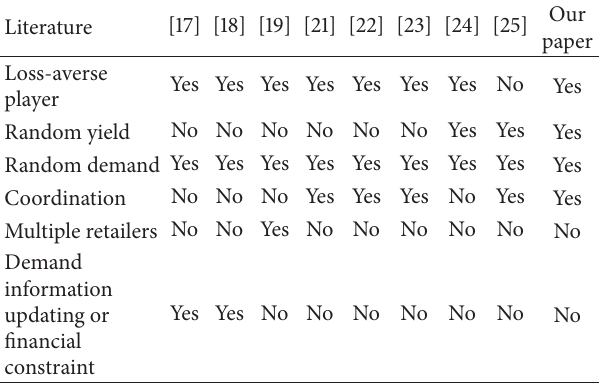
Table 1: Similarities and key differences between our paper and other relevant